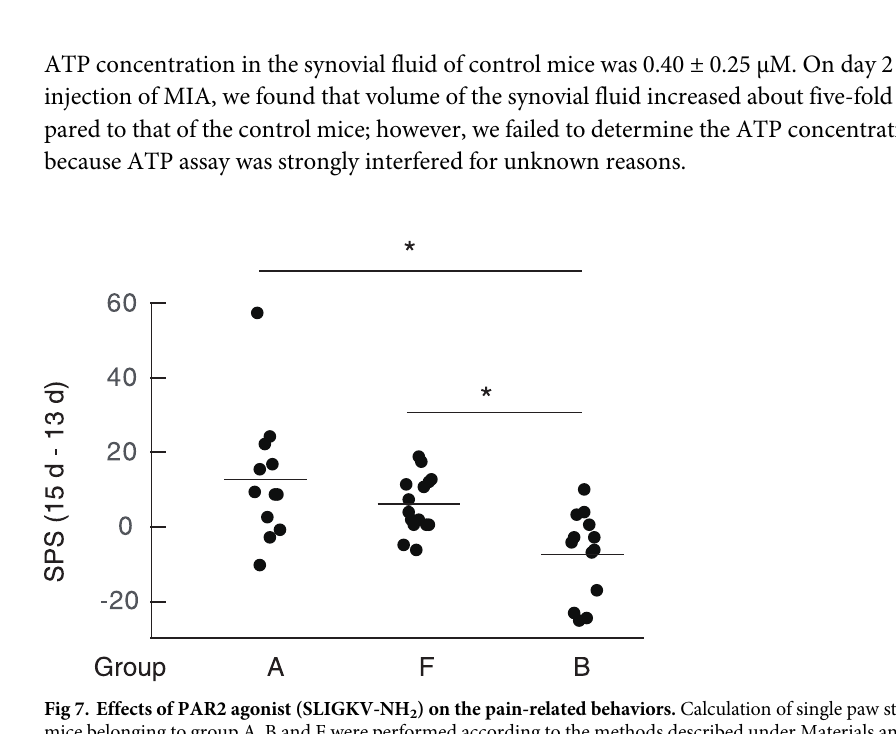
Fig 7. Effects of PAR2 agonist (SLIGKV-NH 2 ) on the pain-related behaviors. Calculation of single paw standing of mice belonging to group A, B and F were performed according to the methods described under Materials and methods. Data from four experiments were combined. Total number of mice used were 13, 15 and 14 for group A, group F and group B, respectively. Each dot represents difference of single paw standing ( Δ SPS) between day 15 and day 13 of a single mouse. Averages were shown by bars. � p <